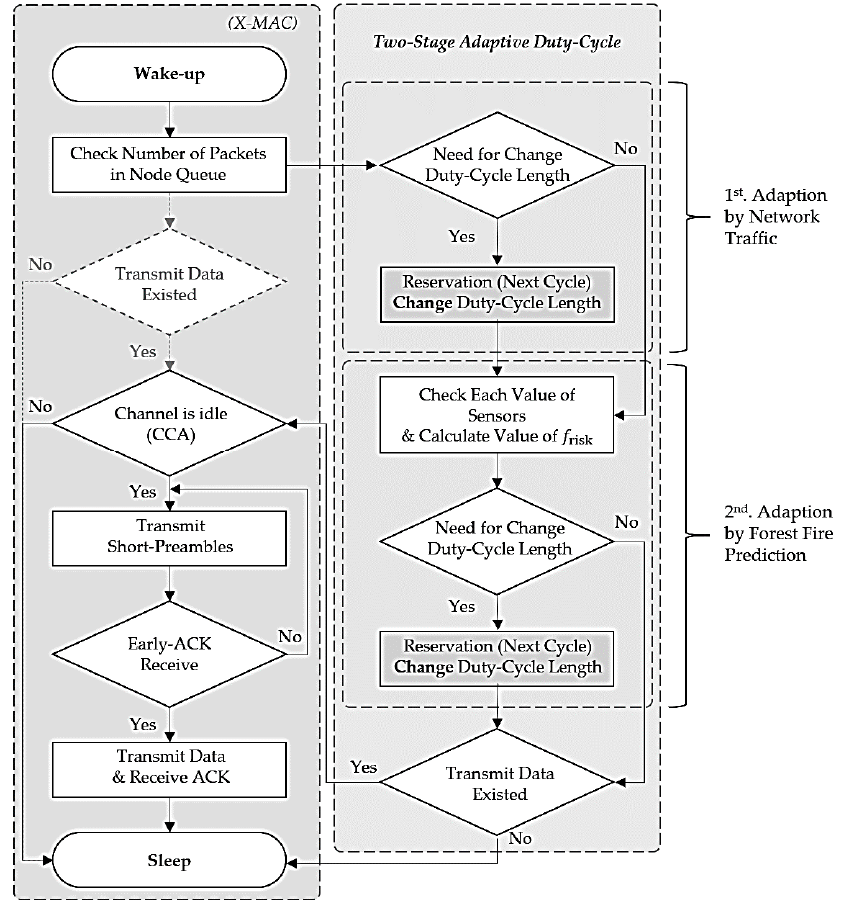
Figure 6. Proposed ADX-MAC algorithm for forest fire.